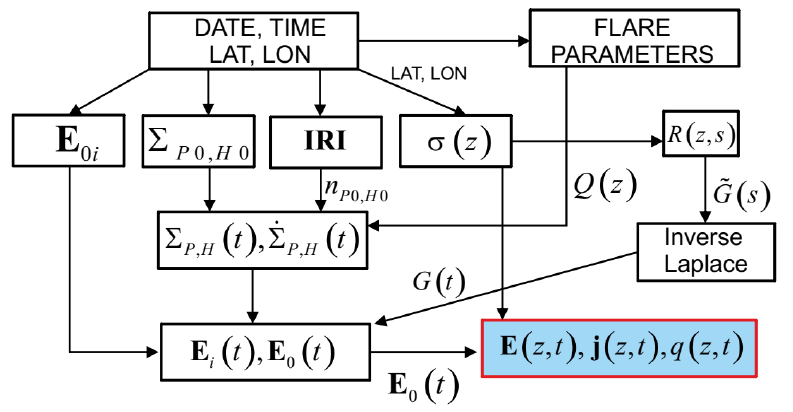
Figure 9. Block diagram of the software package for calculating the spatial distribution of the telluric current.